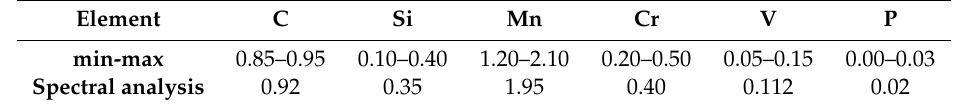
Table 1. Chemical composition of the investigated 90MnCrV8 steel (wt. %).